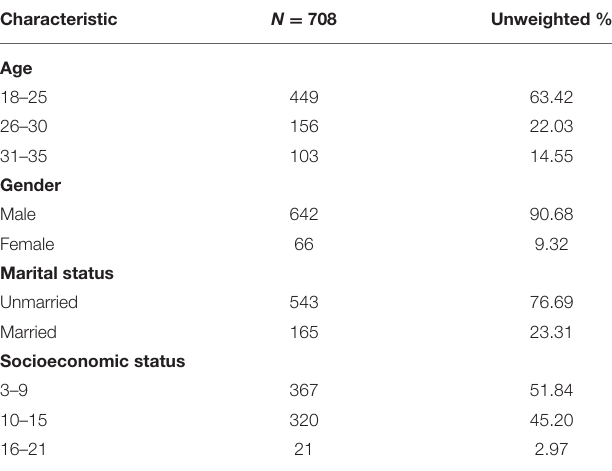
TABLE 1 | Demographic